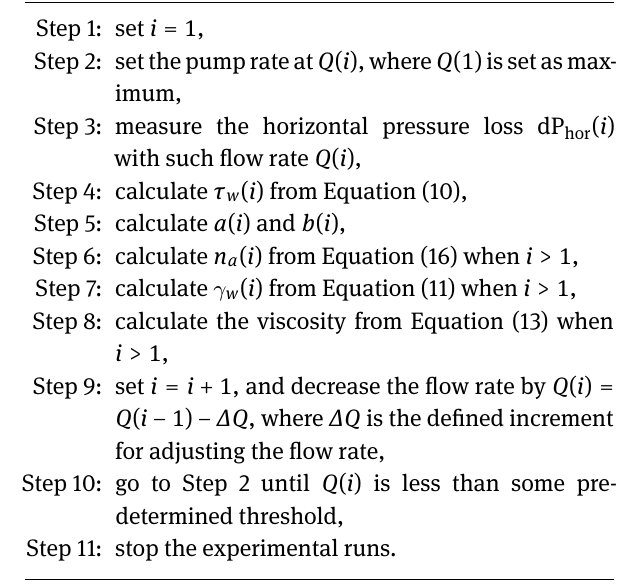
Algorithm 1 (Laminar